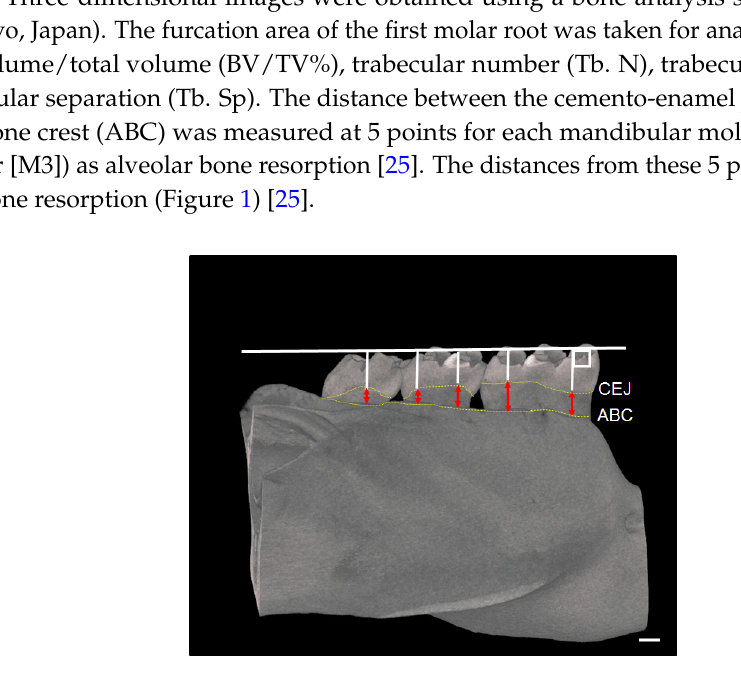
Figure 1. Measurement regions for alveolar bone resorption in rats. The μ CT image shows how to measure the distance between CEJ and ABC. The red arrowheads indicate the degree of alveolar bone resorption. CEJ: cemento ‐ enamel junction; ABC: alveolar bone crest. Bar = 500 μ m.